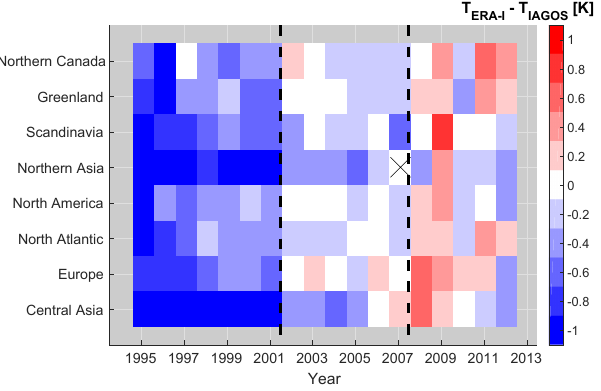
Figure 10. Annual mean of the monthly mean difference between the observations and ERA-I for different regions in the Northern Hemisphere in the lowermost stratosphere from 1995 to 2014. The red colors show that ERA-I temperature is warmer than IAGOS temperature and in blue colors vice versa. The dashed lines show clear break points within the time series. The cross marks a year when the annual mean could not be